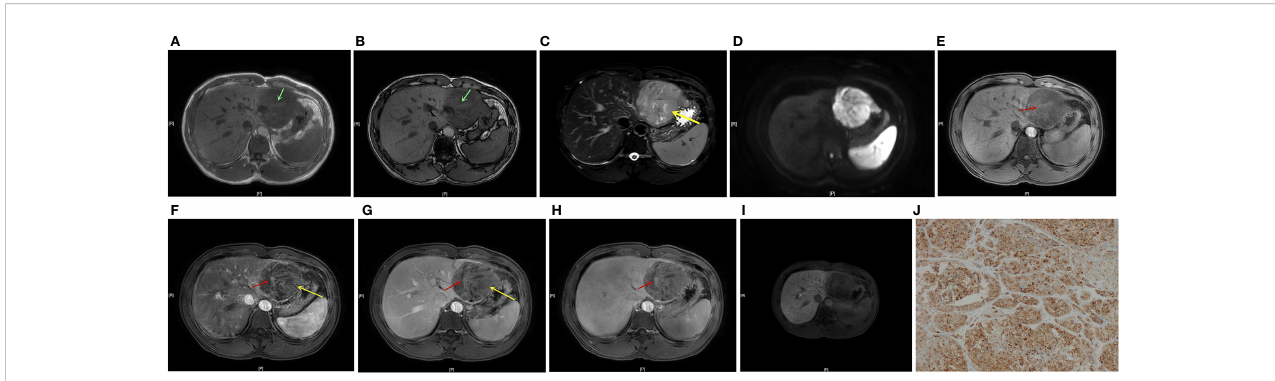
FIGURE 2 A 41-year-old male patient with HCC and positive GPC-3 expression. In-/out-of-phase T1WI showed a 7.1 cm-diameter mass in the left lateral lobe of the liver, with a strip-like hyperintensity in the hypointense background, indicating positive blood products in mass ( A, B , green arrow). T2WI showed mild-moderate T2 hyperintensity in the lesion (C) . DWI showed restricted diffusion in the lesion (D) . Dynamic enhanced MRI showed positive nodule-in-nodule architecture in the lesion ( E-H , red arrow, CER = 0.005). T2WI and the LAP and PVP images showed a mosaic architecture ( C, F, G yellow arrow), and the TP and HBP scans showed a hypointense mass (H, I) . TP-LNR was 0.86, Fer was 178 ug/L, and the patient ’ s total nomogram points was 169 points, indicating that the preoperative risk for positive GPC-3 expression was 91%. The postoperative immunohistochemistry results showed positive GPC-3 expression (J)